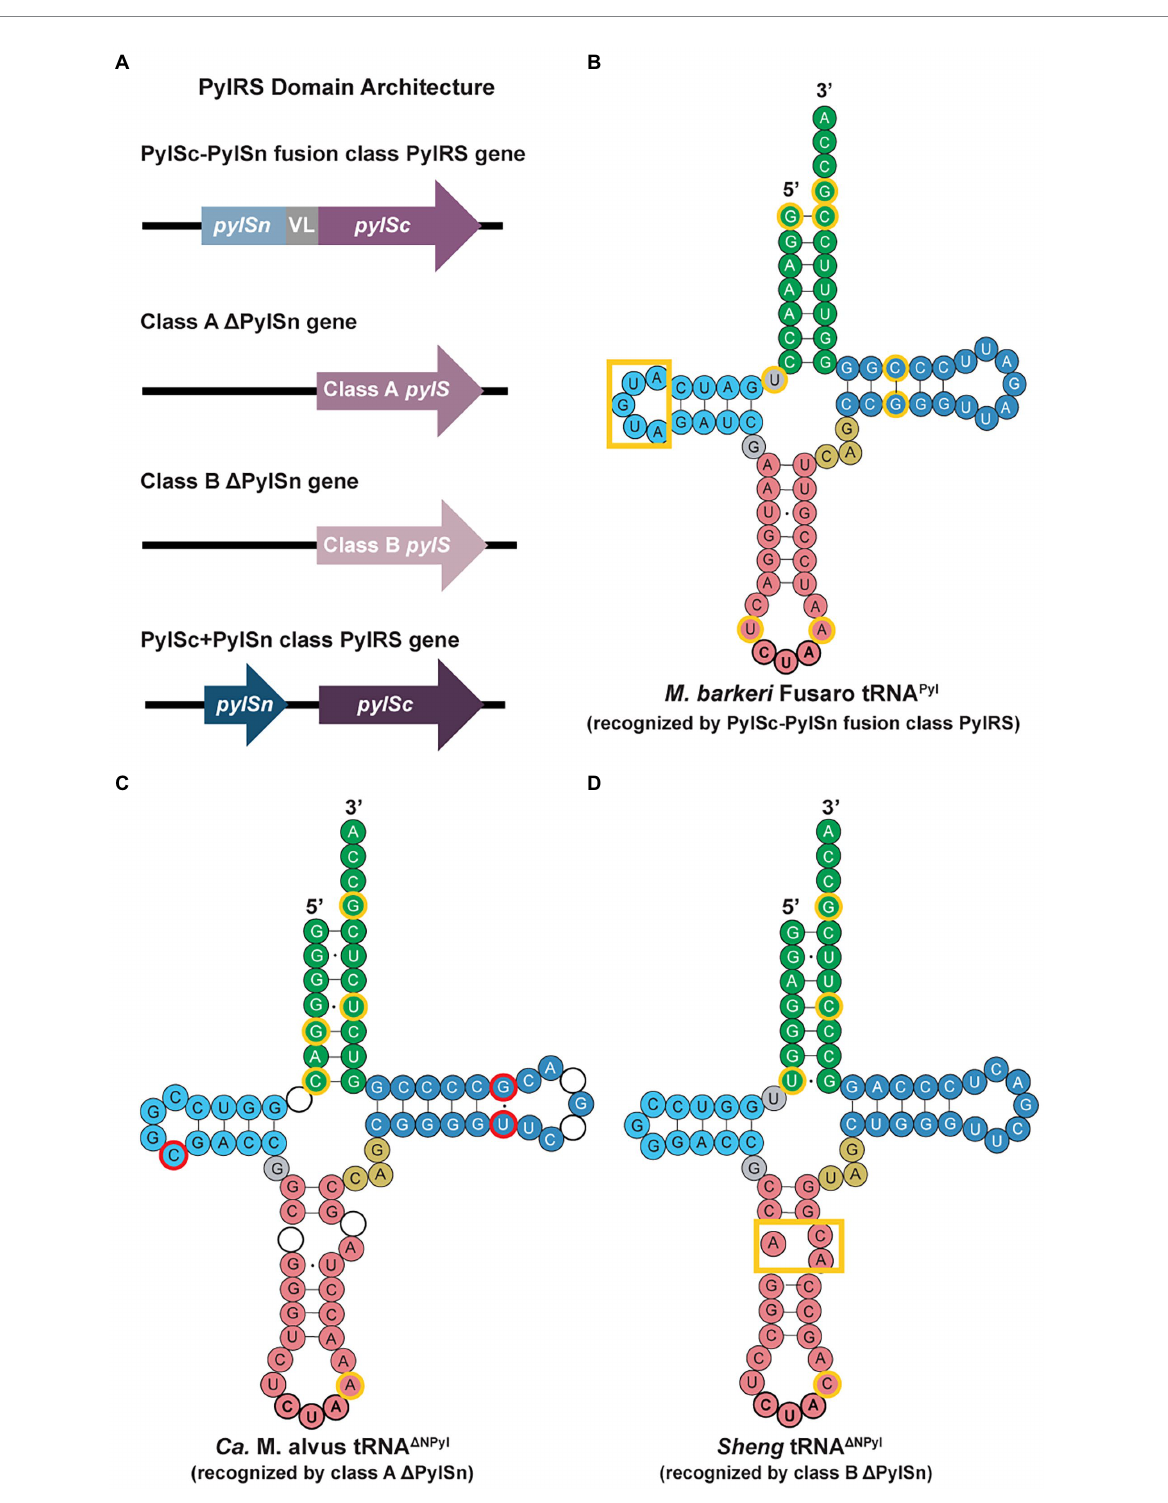
FIGURE 3 PylRS domain architectures and tRNA Pyl secondary structures in archaea. (A) Domains of the PylRS genes from the different enzyme classes highlight the lack of an N-terminal domain for the class A and class B Δ NPylRS and the encoding of the CTD and NTD of PylRS in separate genes for the PylSc+PylSn class. tRNA Pyl secondary structures recognized by (B) PylSc-PylSn fusion class PylRS, (C) class A Δ NPylRS, and (D) class B Δ NPylRS (Dunkelmann et al., 2020). The identity elements for all three classes of tRNA Pyl molecules are outlined in yellow. The tRNA Pyl recognized by class A and B Δ NPylRS (tRNA Δ NPyl ) noticeably contain a break or bulge in the anticodon stem (pink). For the class A tRNA Δ NPyl , nucleotides highlighted in red represent bases that are missing in the sequence of other class A tRNA Δ NPyl , whereas circles without nucleotides represent those that are missing in the Ca. M. alvus sequence but present in others of the same